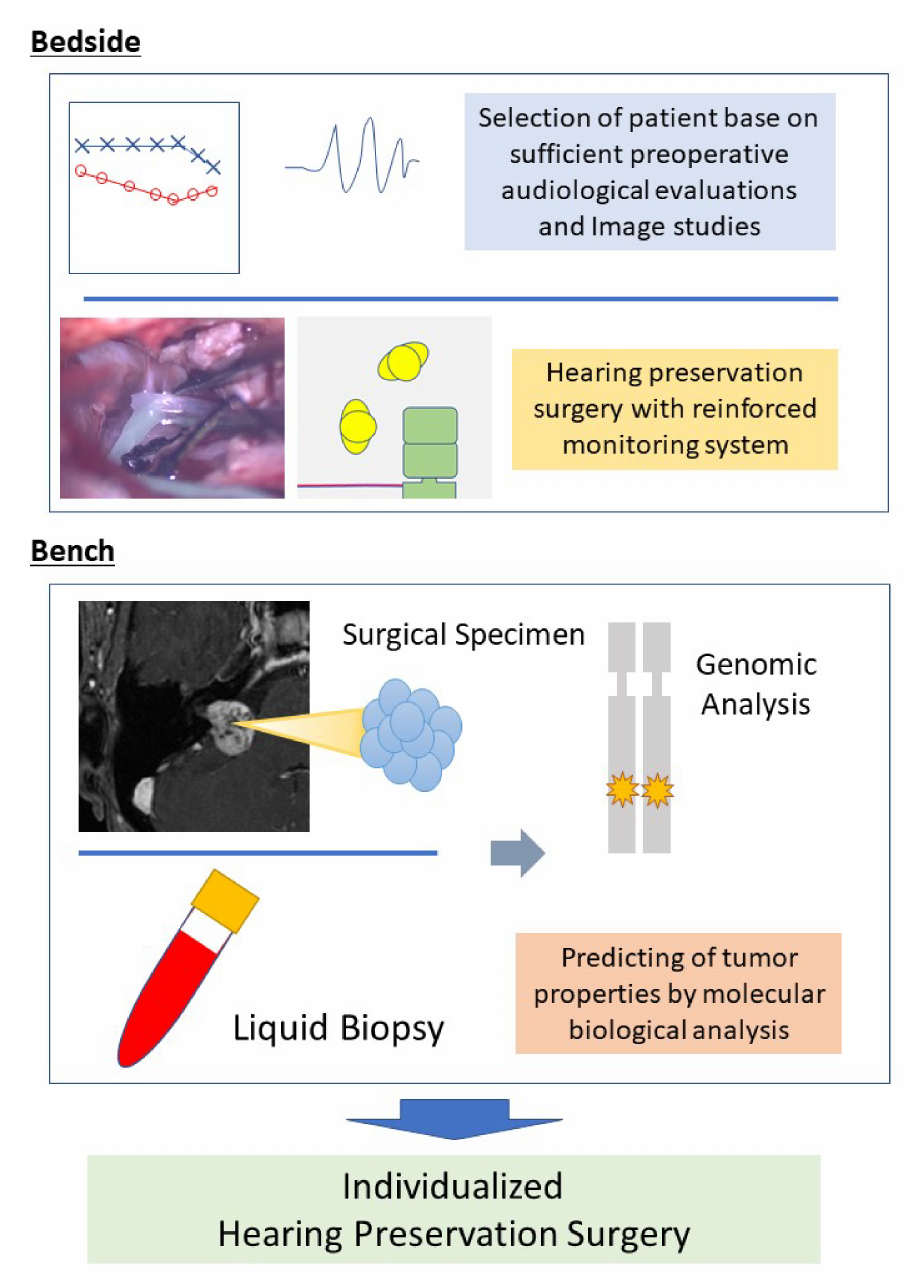
Figure 6. Future directions of hearing preservation surgery combining bedside and bench.